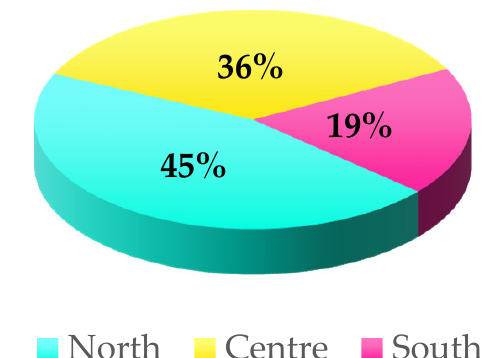
Figure 1. Italian breeders’ distribution by region.